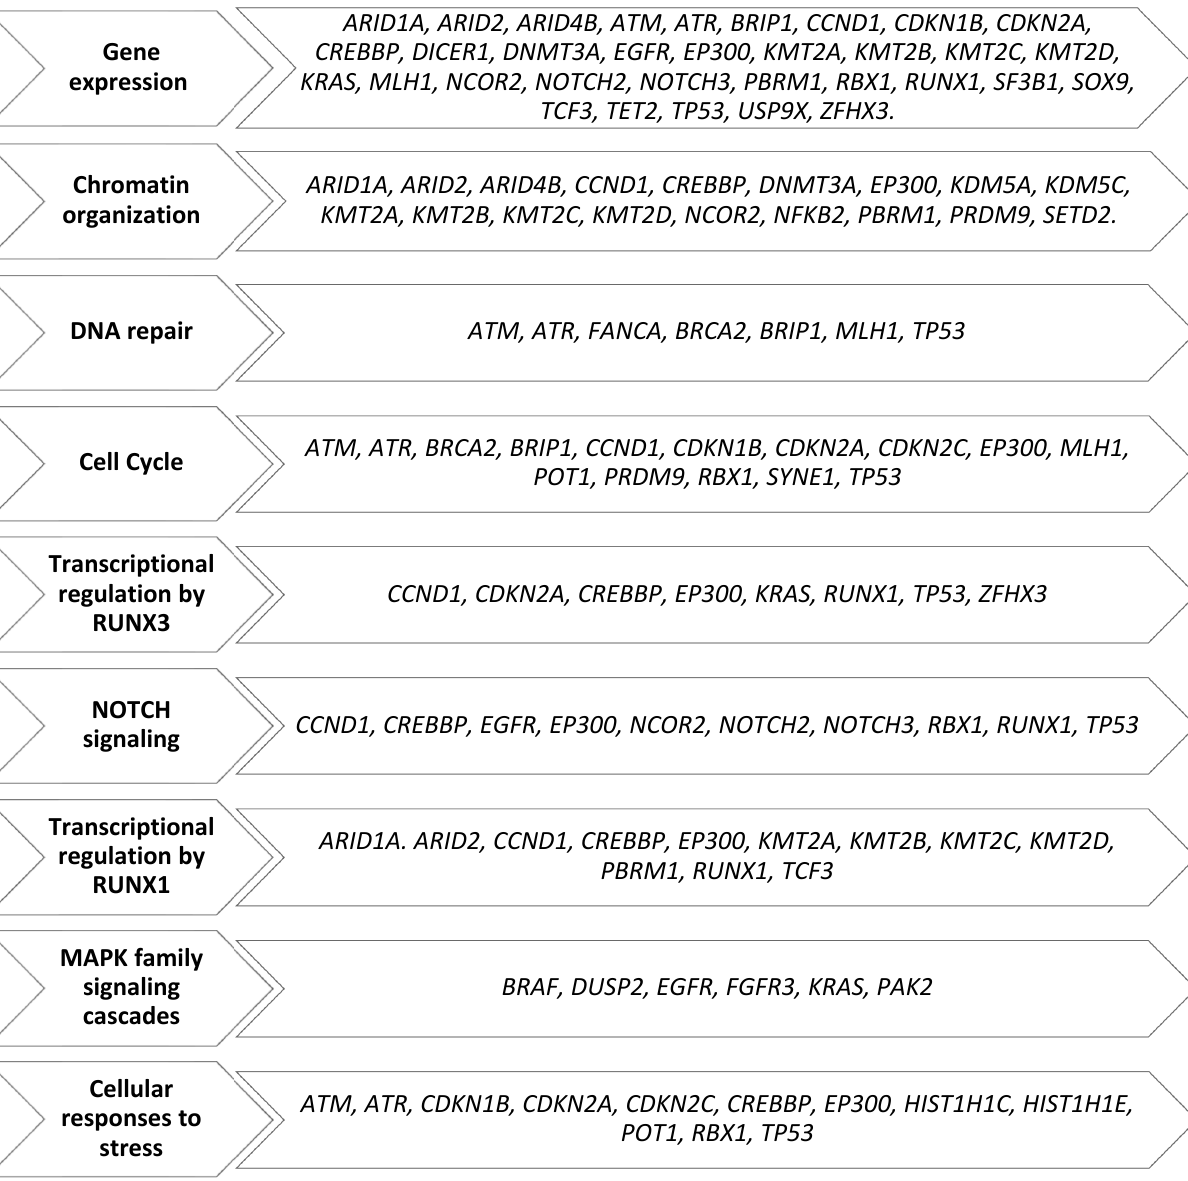
Figure 1. The functional categorization of all mutant genes.